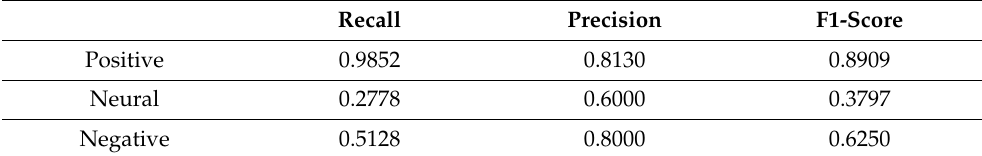
Table 4. The performance measurements of